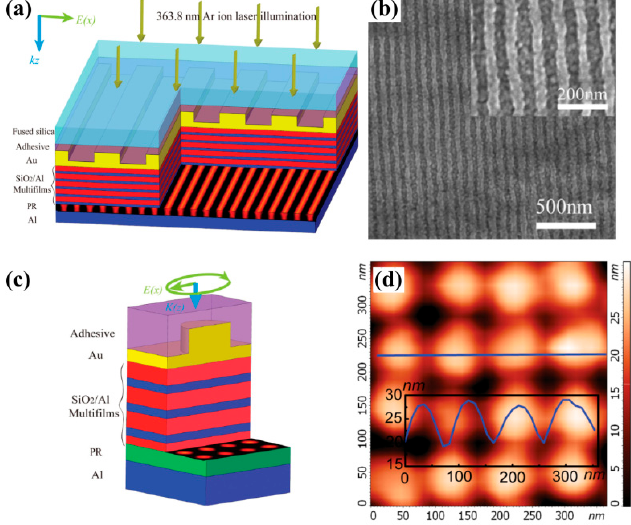
Figure 10. ( a ) Schematic configuration of two-BPPs’ interference; ( b ) SEM image of exposure photoresist; ( c ) Schematic configuration of four-BPPs’ interference; ( d ) AFM image of two-dimension interference pattern. Feature size of results is 45 nm. Reproduced from [37], Copyright © 2015, WILEY.